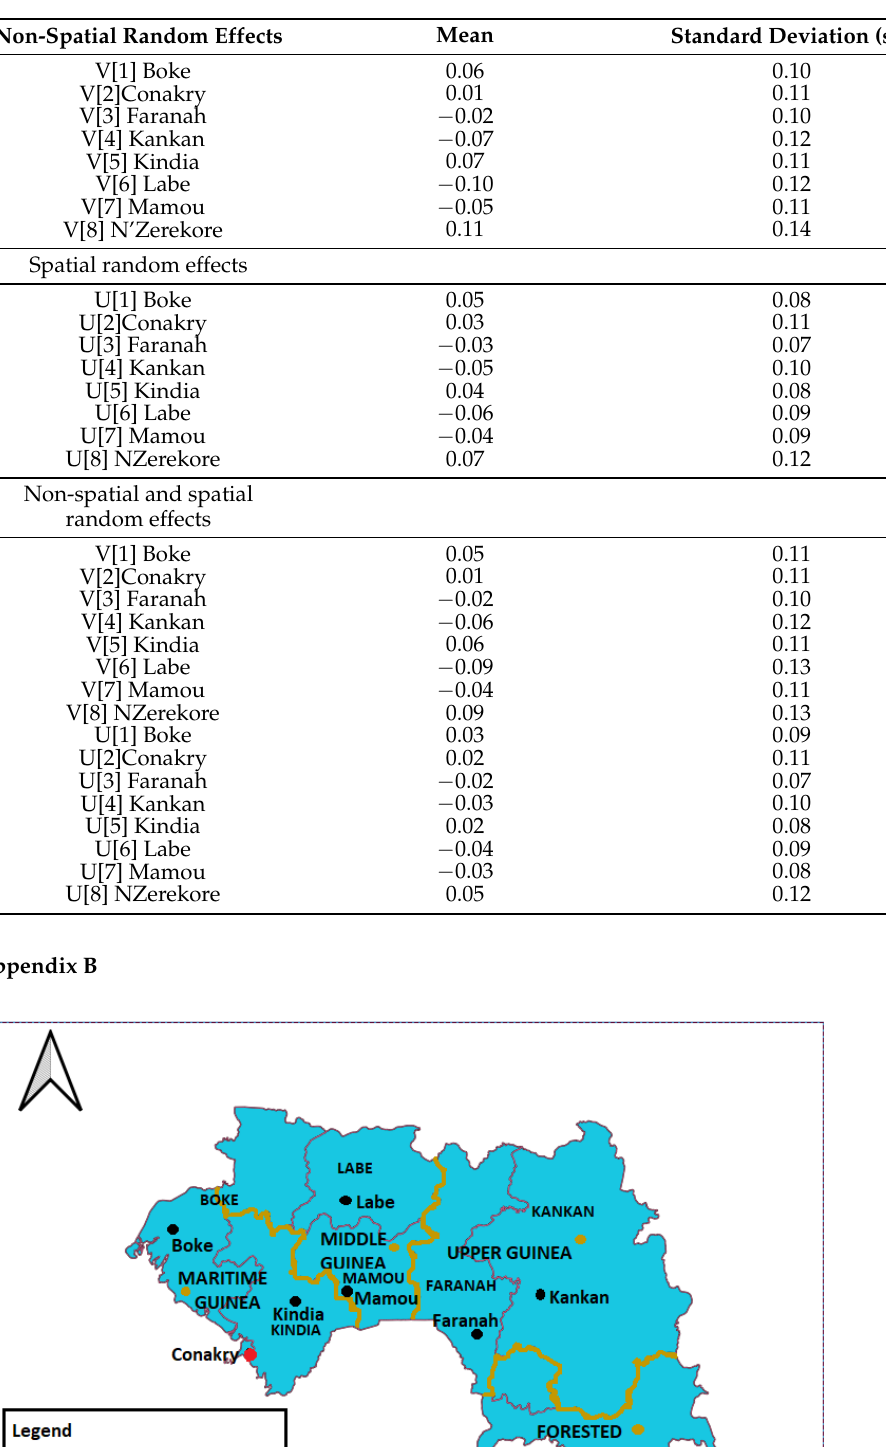
Table A1. Summary of models fit.